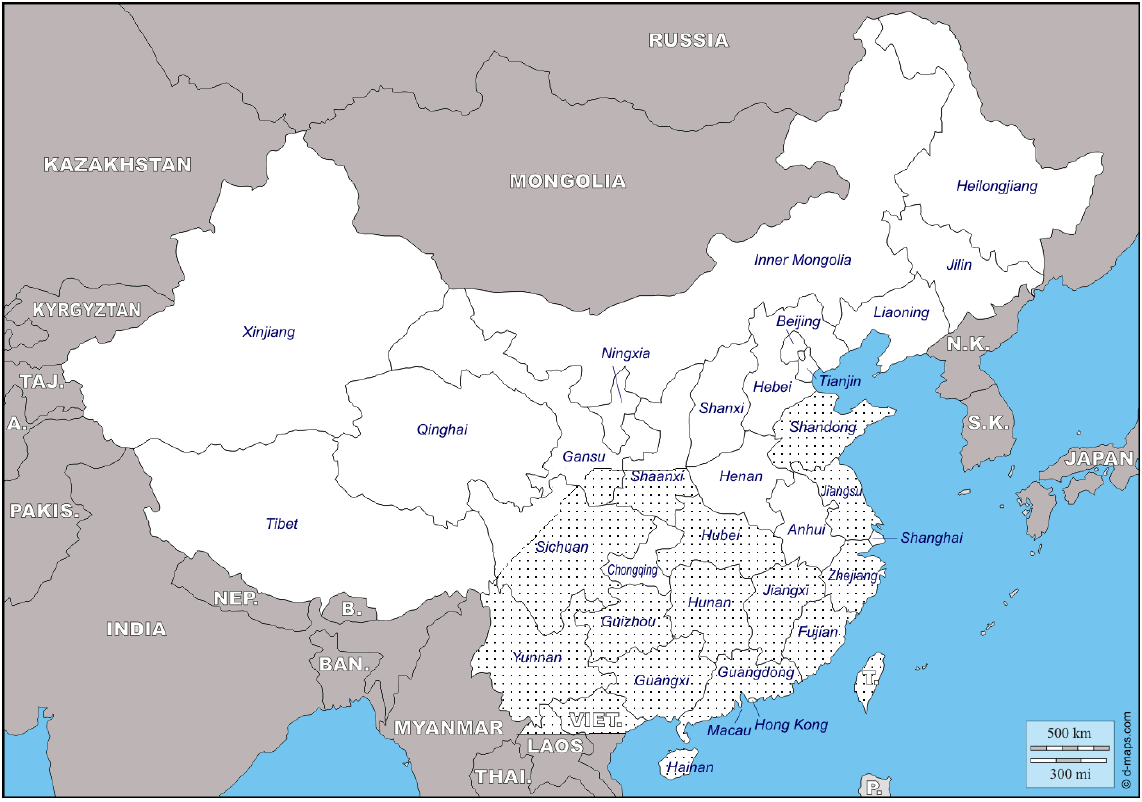
Fig. 4. Dotted area: approximate distribution of Hybovalgus . Original map from http://www.d-maps.